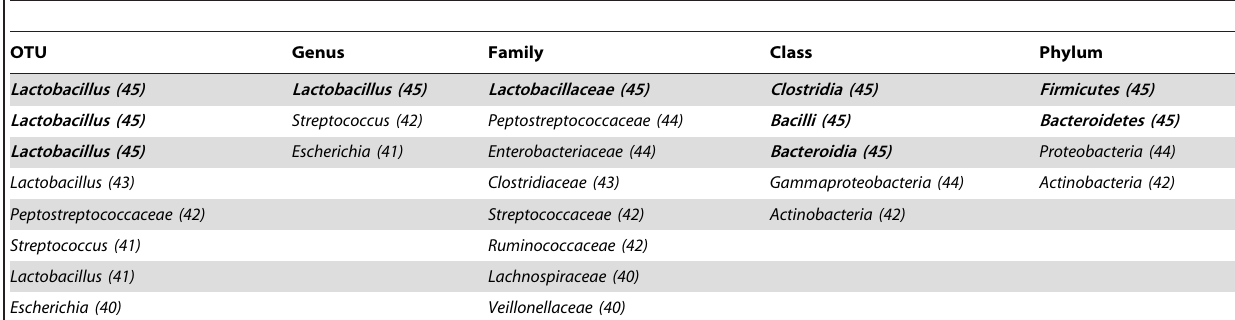
Table 1. List of OTUs and their taxonomic classification found in at least 40 out of 45 samples tested by pyrosequencing 16S rRNA genes.